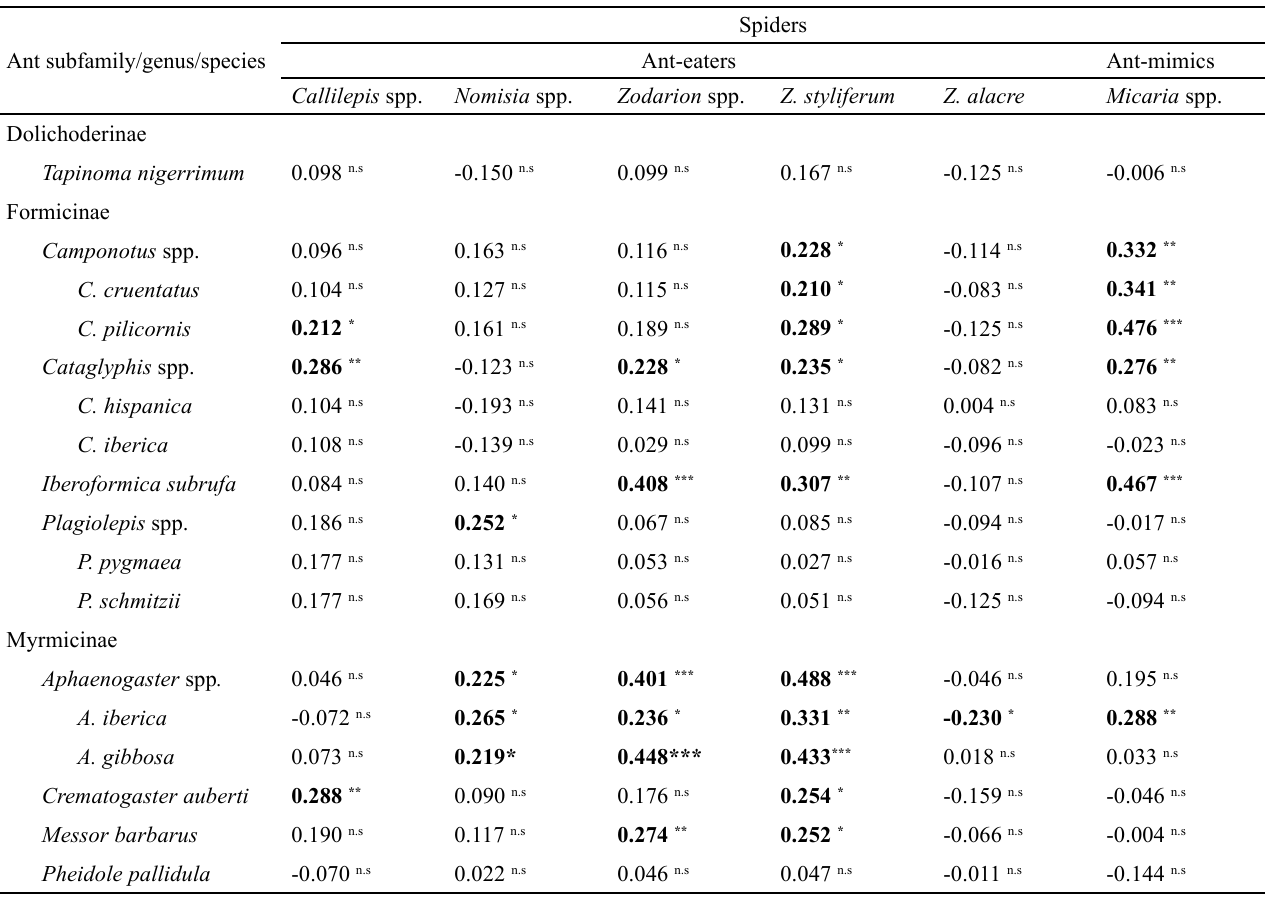
Table 2 . Spearman correlation coefficients (Rho) between abundance of ant -associated spiders and abundance of ants (genera and species). Only genera /species with at least five occurrences were included in the